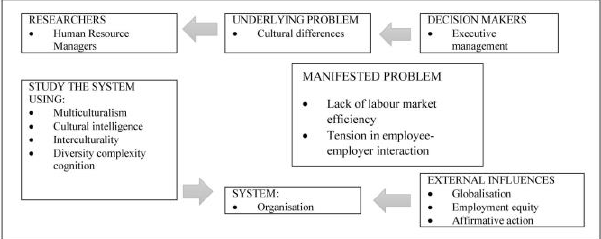
Figure 1: Organisational systems analysis (adapted from Levien,